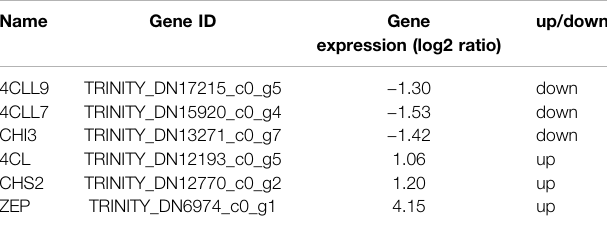
TABLE 4 | Candidate genes differentially expressed in single-head root and double-head root